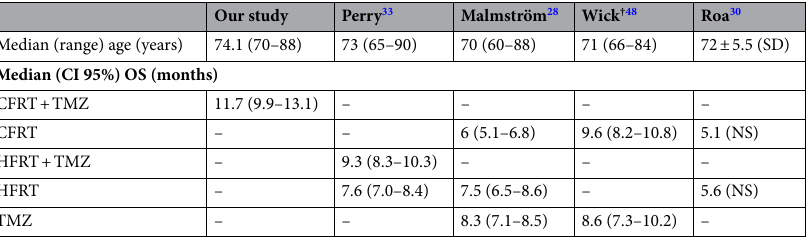
Table 4. Median overall survival (OS) from prospective randomized trials with different post-operative modalities compared to our study. CFRT conventionally fractionated RT, HFRT hypofractionated RT, TMZ temozolomide, SD standard deviation, NS not specified. † Patients with malignant anaplastic astrocytoma were also